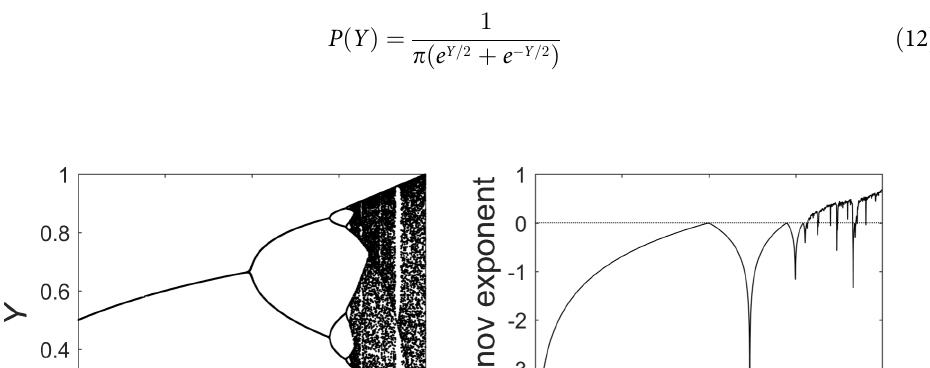
(cid:1) to the iterates of the Logistic Map with A = 4